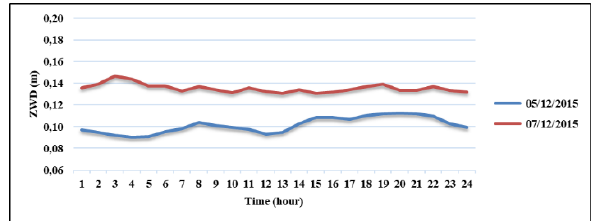
Figure 8. PM 10 time series of Zonguldak.